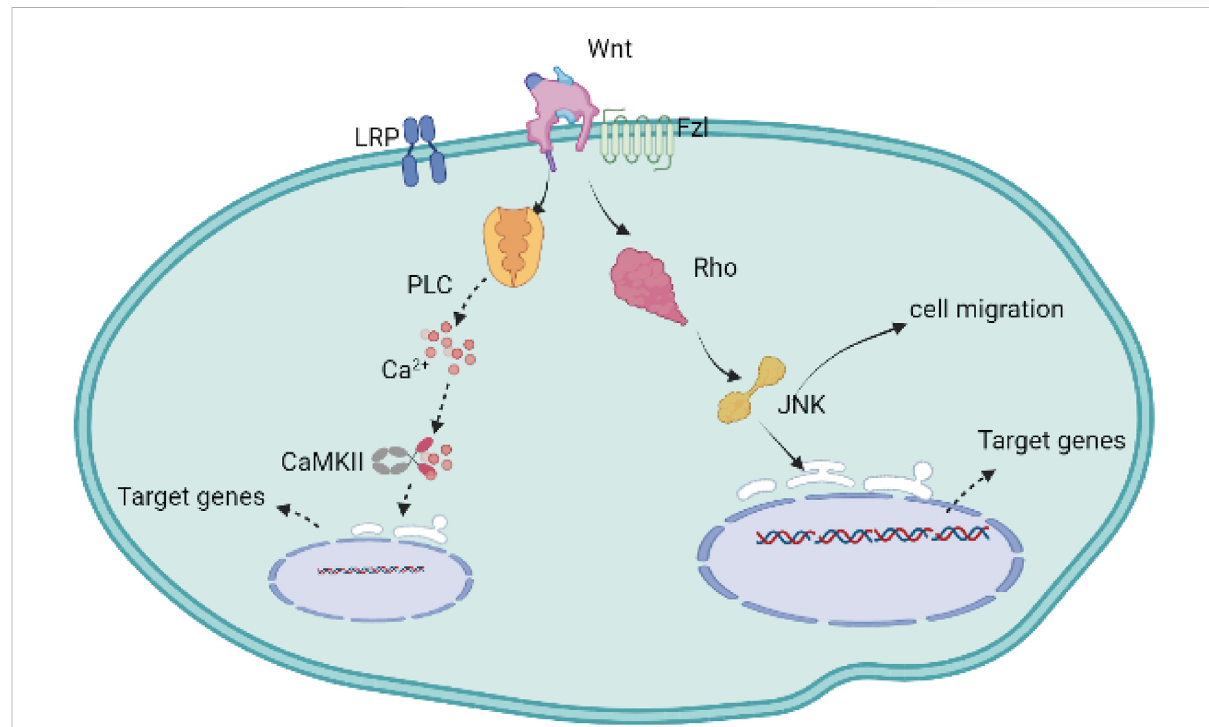
FIGURE 2 The non-canonical Wnt signaling cascade is activated without the involvement and activation of β -catenin. The Wnt protein binds to Fzl and other ligand receptors without the engagement of the LRP co-receptors. One of these cascades is triggered by the stimulation of the intracellular Ca 2+ secondary to the production of the cytoplasmic PLC, subsequently activating the transcription factors in cell nucleus through the regulation of CaMKII;theothernon-canonicalWntsignalingcascadereliesontheincreaseofRhofollowingtheactivationofmitogen-activatedkinasessuch as c-Jun N-terminal kinase (JNK), targeting the genes, and regulating cell proliferation and